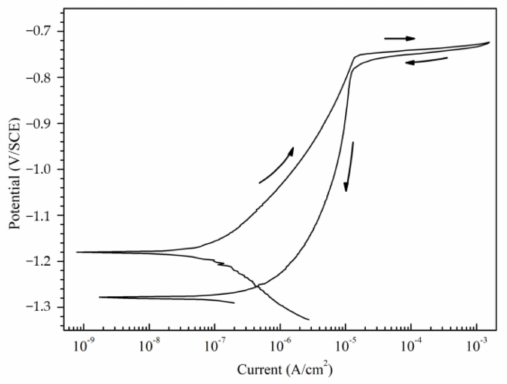
Figure 4. Cyclic polarization curve of pure Al (99.99%) in 5 wt % NaCl